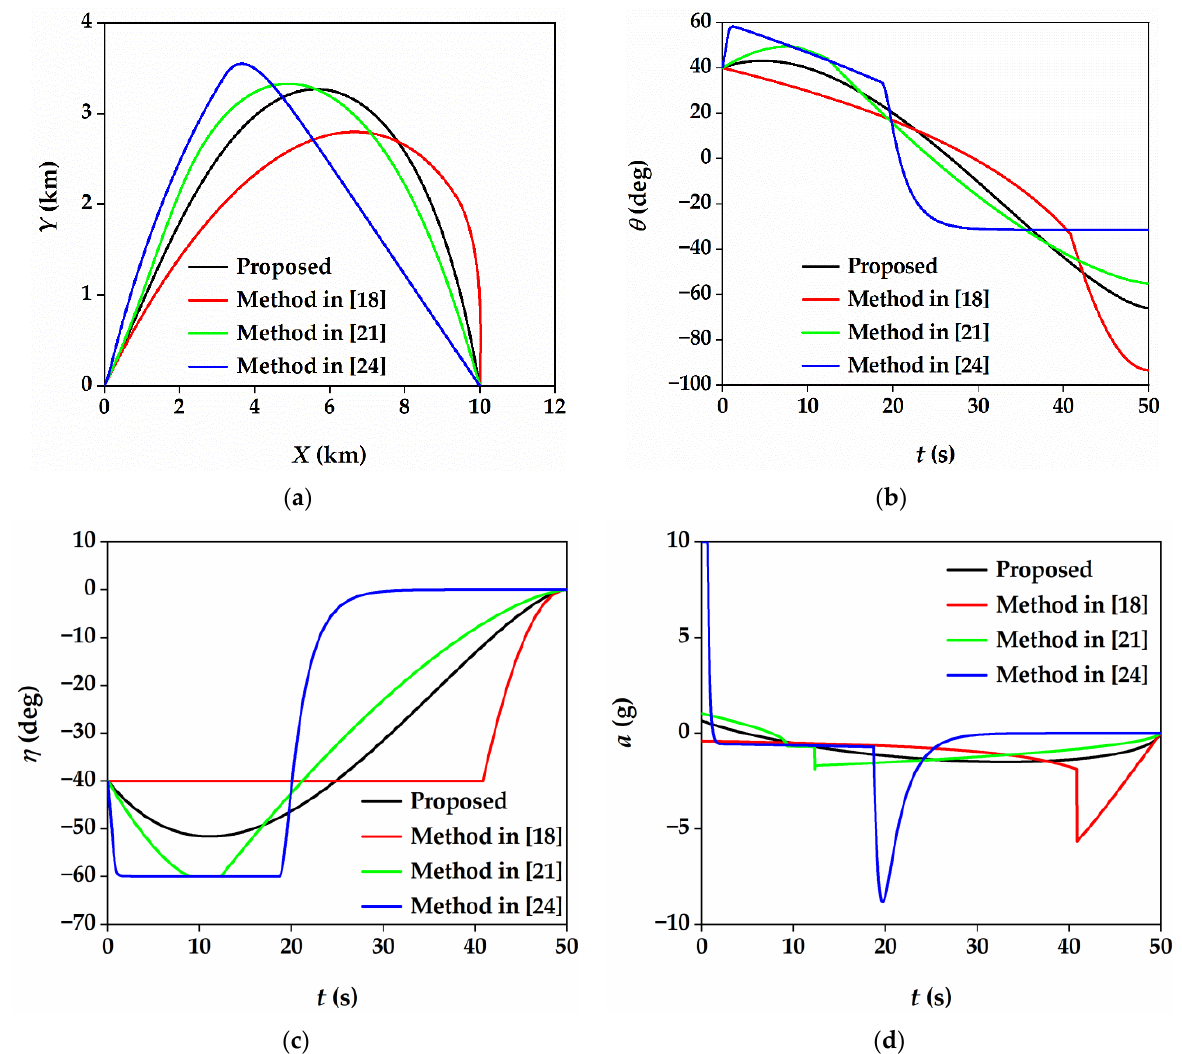
Figure 5. Simulation results of θ 0 = 40° under different guidance laws. ( a ) Missile flight trajectory; ( b ) Flight path angle; ( c ) Lead angle; ( d ) Missile acceleration.